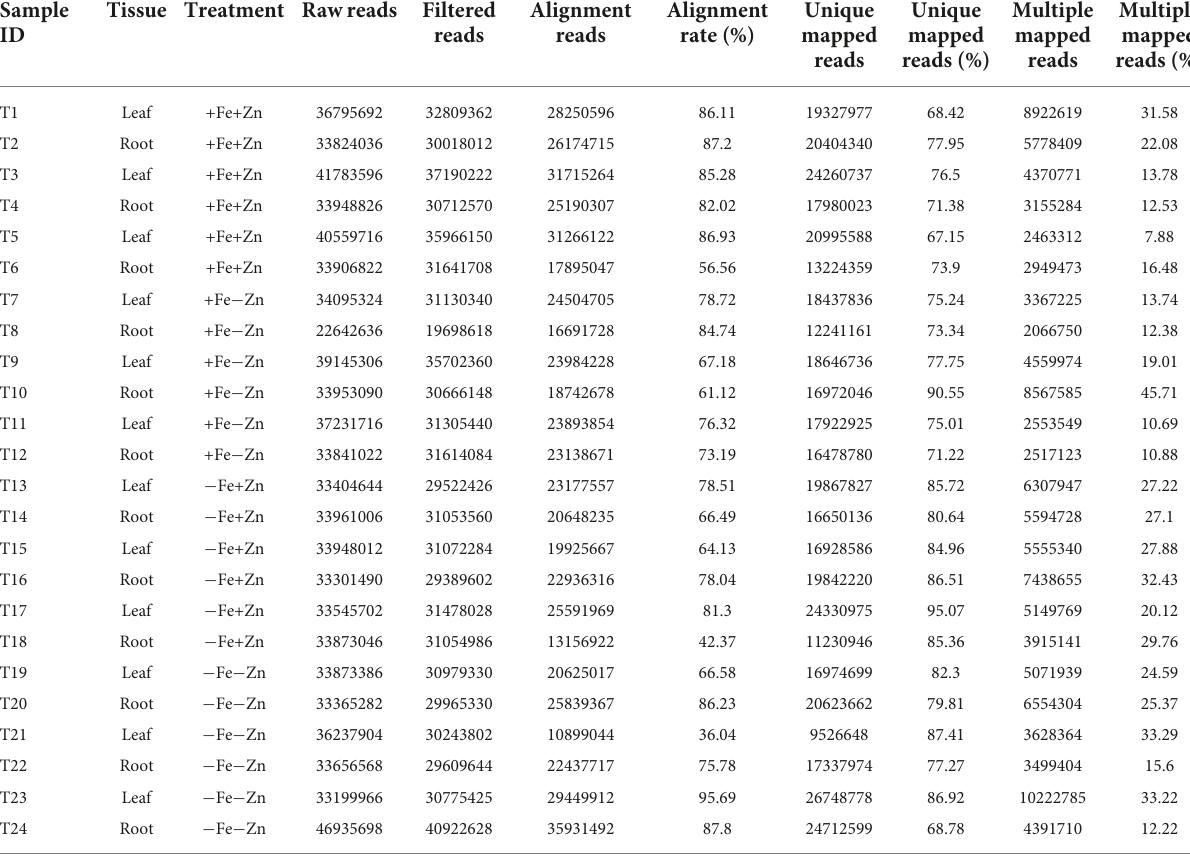
TABLE 2 Total and mapped reads obtained from different treatments of Fe and Zn stresses in leaf and root samples of pearl millet through RNA-Seq analysis. Sample